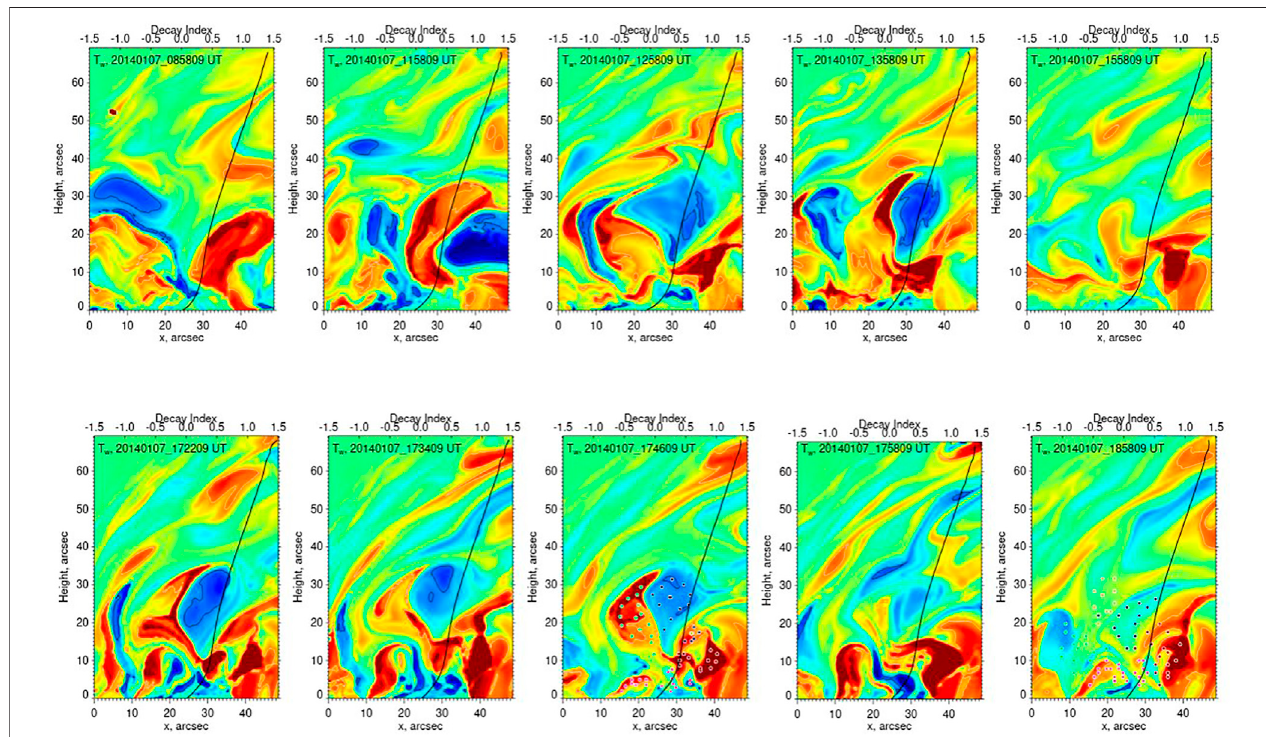
FIGURE 4| Field line twist, T W , maps shown for several instancesfor the west fl ux rope (FR). The T W wascalculated on a vertical plane orthogonal to the axis of an eruptive AR fi lament. Theimagesare scaled between − 2 < T W < 2, whilecontours outline areas with | T W | > 1. The black curveis thedecay index pro fi le calculated along the fl aring PIL at x = 25 ″ . The x -axis begins at the top end of the cross-section (Figure 1) and the sunspot is outside the FOV on the left side of the panels. The y -axis represents the height above the photosphere. The color coded dots in 17:46:09 and 18:58:09 UT panels indicate the locations through which we traced the fi elds lines shown in Figure 5 .